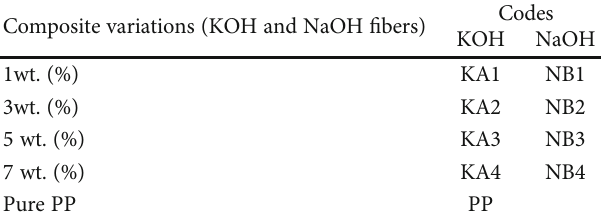
Table 1: Composites percentage variations and codes. Composite variations (KOH and NaOH fi bers)